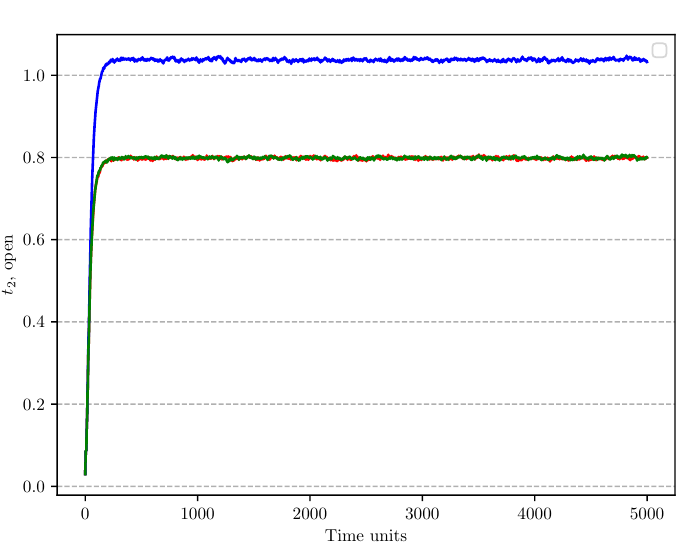
= 0.798 ( 3 ) and the third has 2